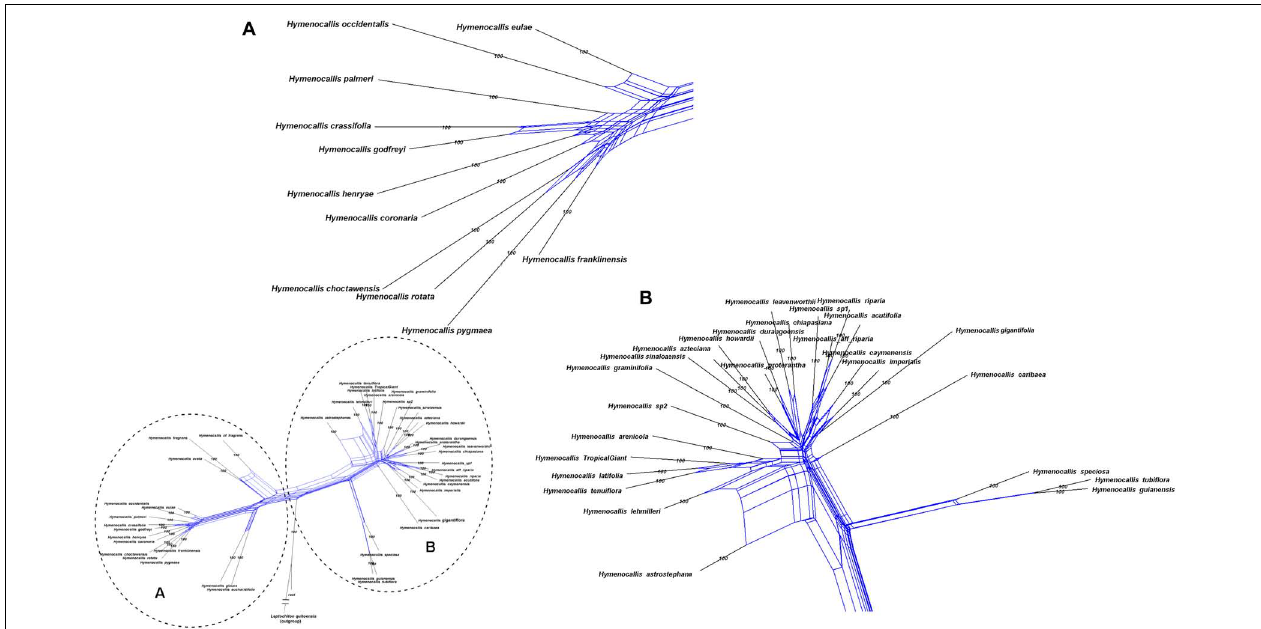
FIGURE 8 | Equal angle 360 ◦ hybridization network generated by SplitsTree v. 4.15.1 based on the 99% taxon coverage supermatrix (70 nuclear genes) across the genus Hymenocallis , with percentages from 300 bootstrap iterations. The entire network is shown in the inset, with subclades (A) and (B) magnified for clarity.